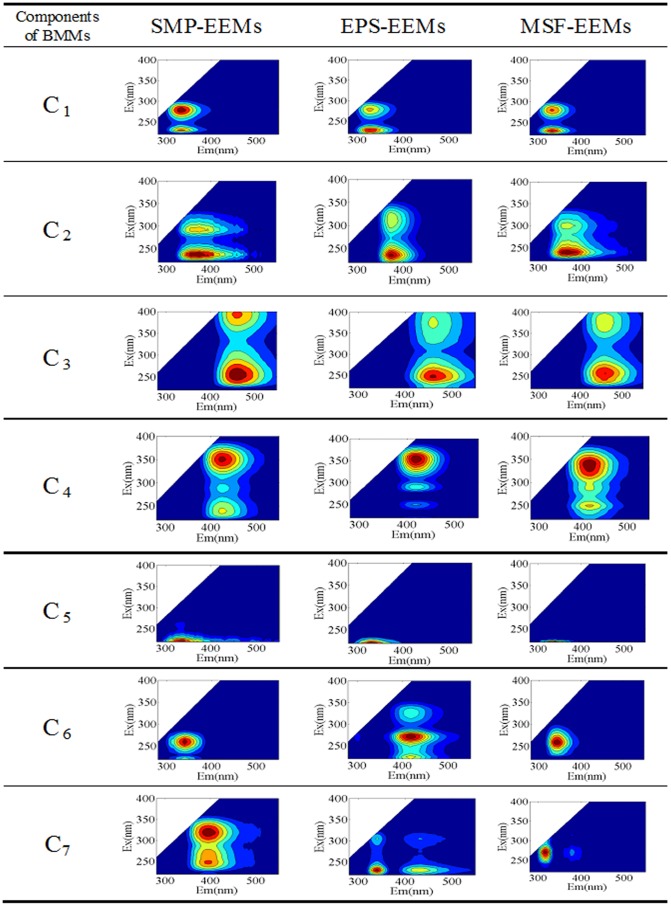
Contour plots of the seven components identified from the SMP-EEMs, EPS-EEMs and MSF-EEMs dataset.